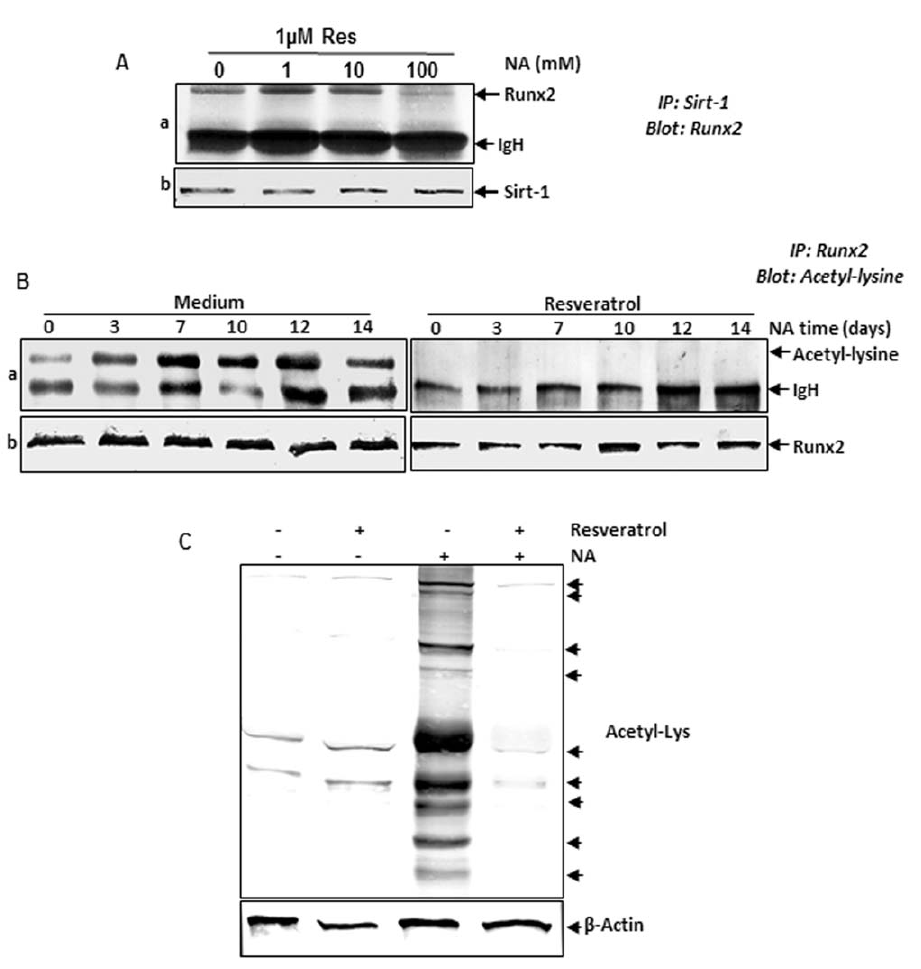
Figure 6. Association of Sirt-1 proteins with the early osteogenic transcription factor Runx2 during osteogenesis. A: Effect of resveratrol and NA on association of Sirt-1 proteins with Runx2 during osteogenesis in MSC high-density cultures. Cultures were pre-treated with 1 m M resveratrol for 4 h followed by co-treatment with nicotinamide 1, 10, 100 mM over 14 days with osteogenic induction medium. Cultures were lysed and immunoprecipitated with anti-Sirt-1 antibody. The immunoprecipitates were separated by SDS-PAGE and analyzed by immunoblotting using anti-Runx2 antibodies (a). The same blots were re-probed with an antibody to anti-Sirt-1 (b). Results shown are representative of three independent experiments. IgH, immunoglobulin heavy chain. B: Effect of resveratrol on NA-induced acetylation of Runx2 during osteogenesis in MSC high-density cultures. Cells were treated with 10 mM nicotinamide or pre-treated with 1 m M resveratrol for 4 h followed by co-treatment with 10 mM nicotinamide over 14 days with osteogenic induction medium. Whole-cell extracts were prepared, immunoprecipitated with an anti-Runx2 antibody, and subjected to western blot analysis using an anti–acetyl-lysine antibody (a). The same blots were re-probed with an antibody to anti-Runx2 (b). C: Effect of resveratrol on NA-induced protein acetylation. Cells were treated with 1 m M resveratrol for 4 h and then exposed to 10 mM nicotinamide over a